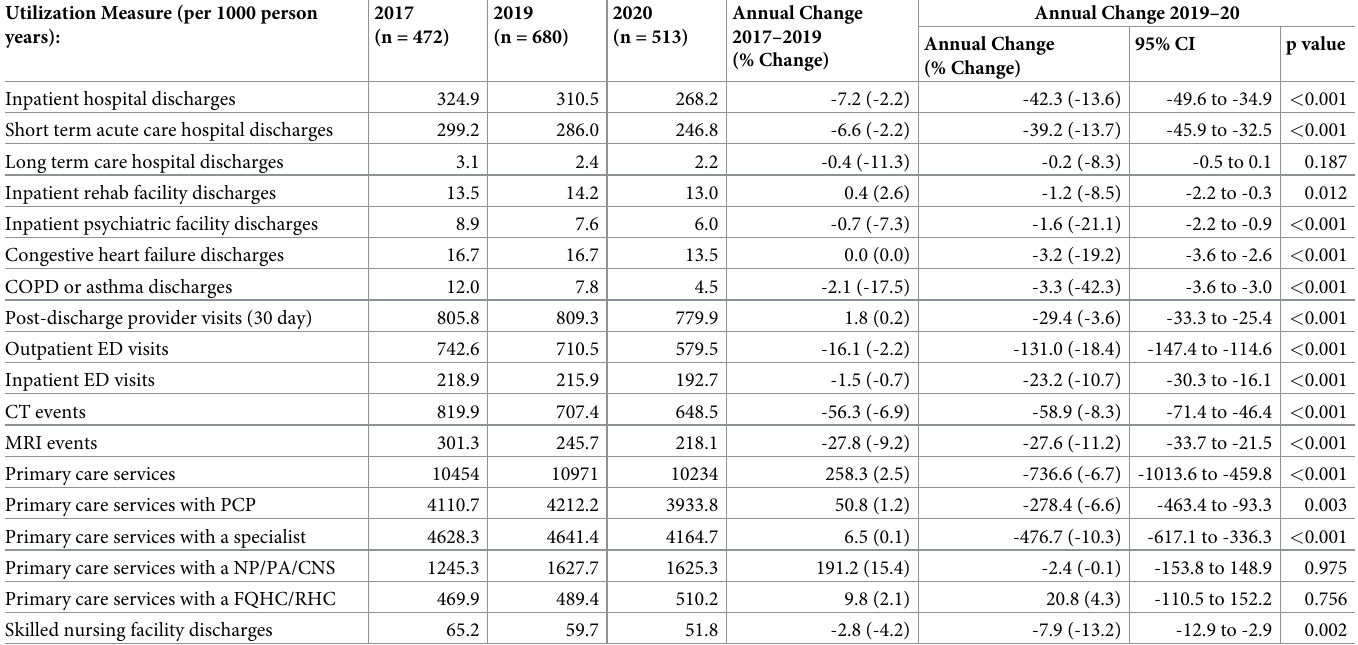
Table 2. Changes in utilization,